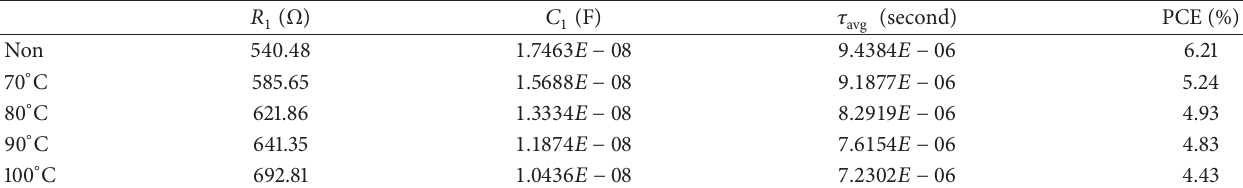
Table 2: The simulated data of 𝑅 1 and 𝐶 1 by applying the Cole-Cole plot into equivalent